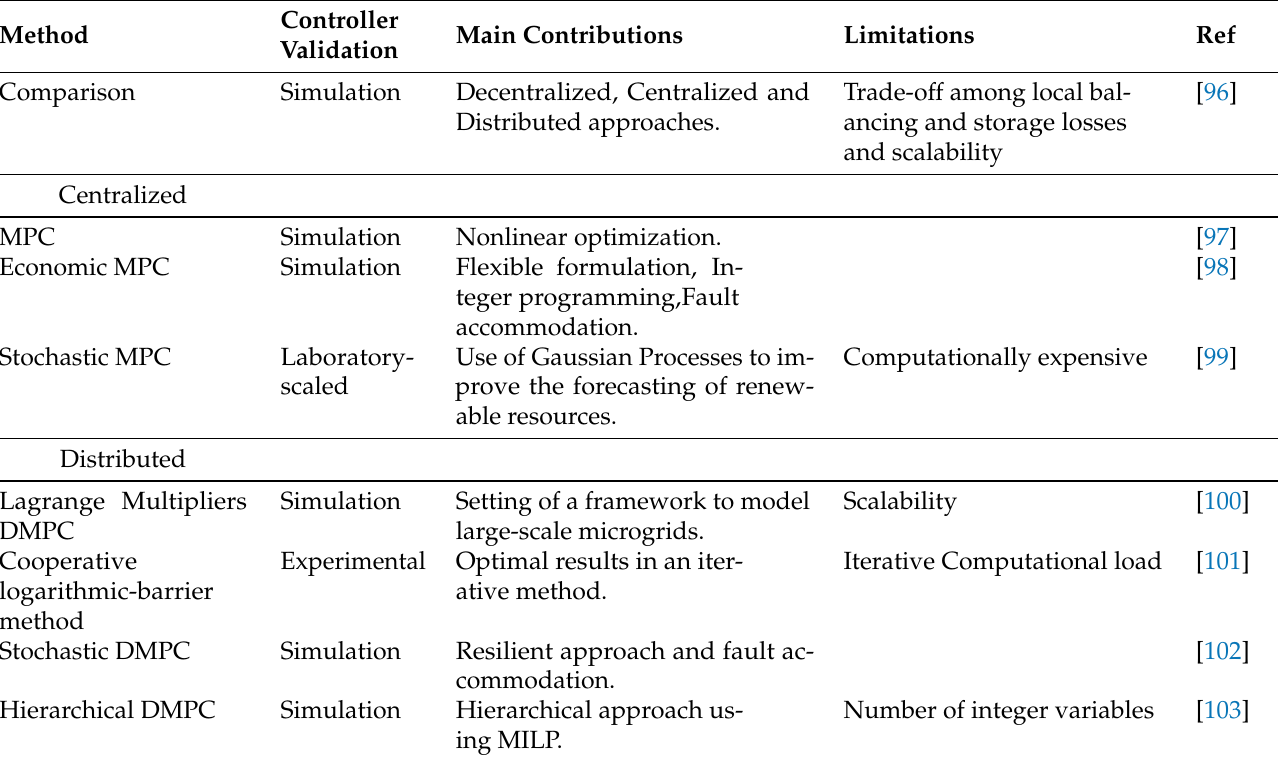
Table 3. Application of MPC schemes for interconnected